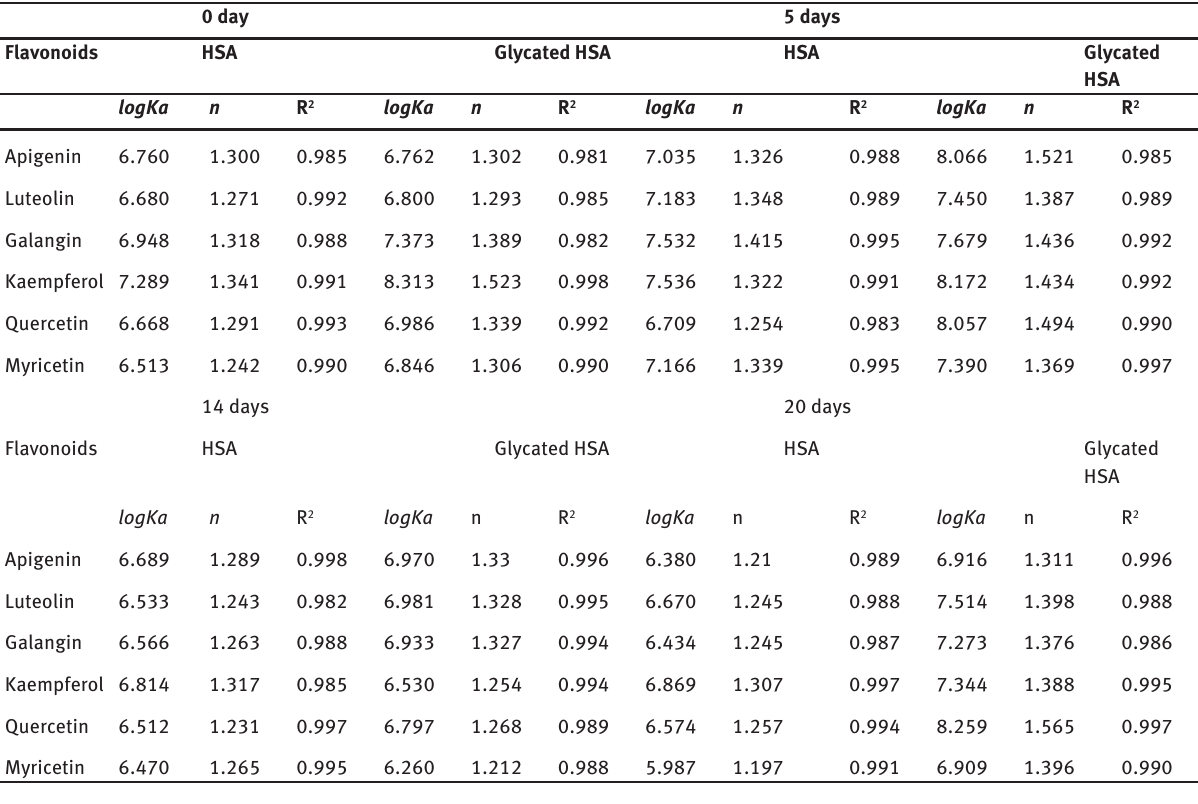
Table 2: The affinities (log Ka ), the number of binding sites ( n ) and corresponding fitting degrees of flavonoids for HSA and glycated HSA. 0 day 5 days Flavonoids HSA Glycated HSA HSA Glycated